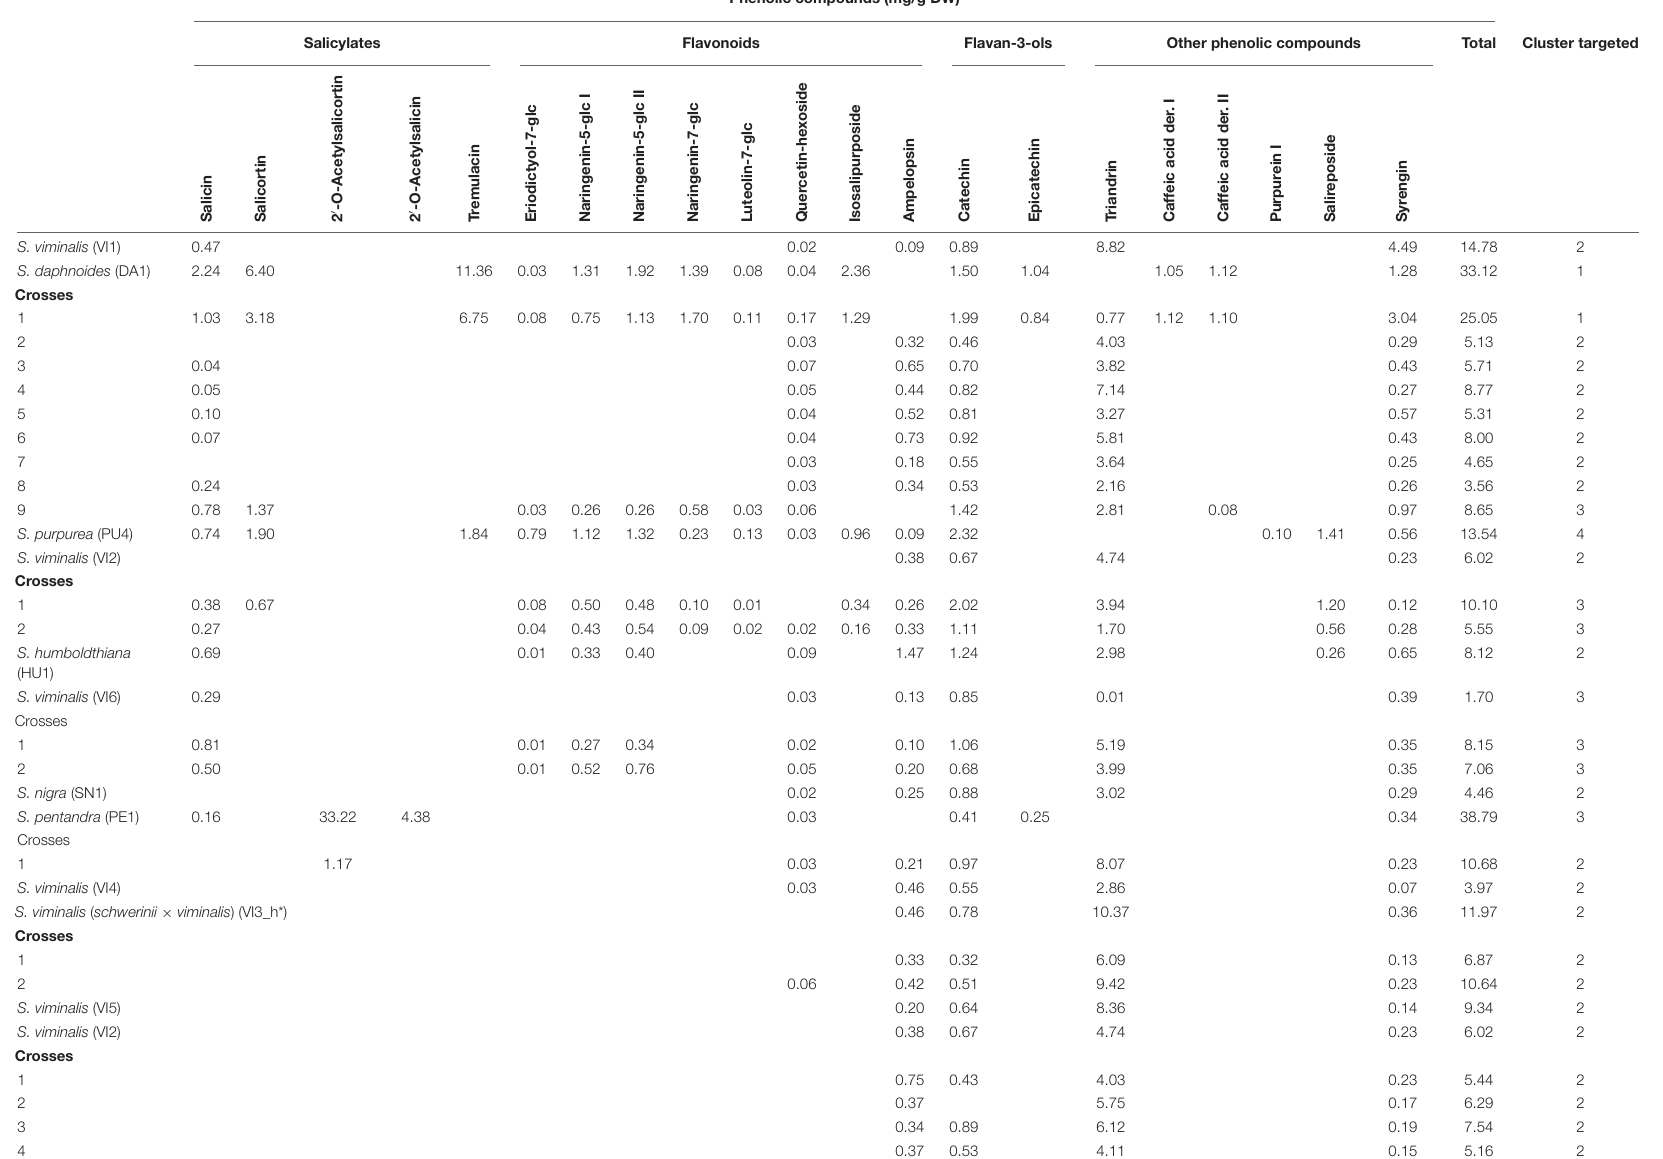
TABLE 2 | Phenolic compound profile of clones of S. viminalis , S. daphnoides , S. purpurea , S. humboldtiana , S. nigra , S. pentandra , and their